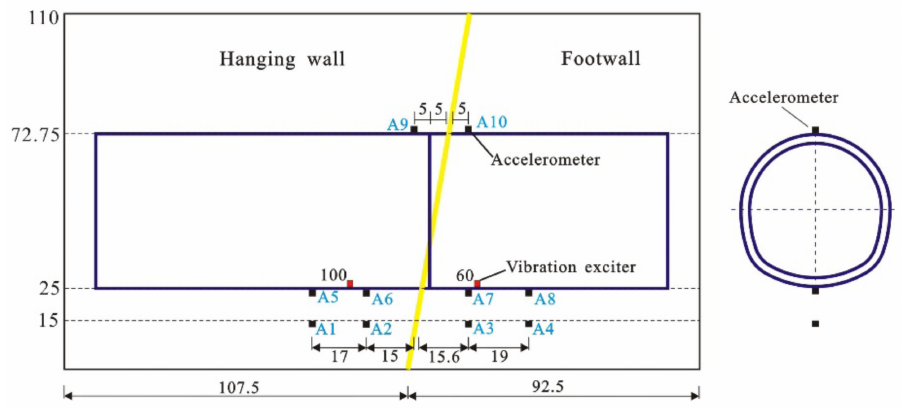
Figure 5. Layout of vibration exciters and accelerometers (unit: